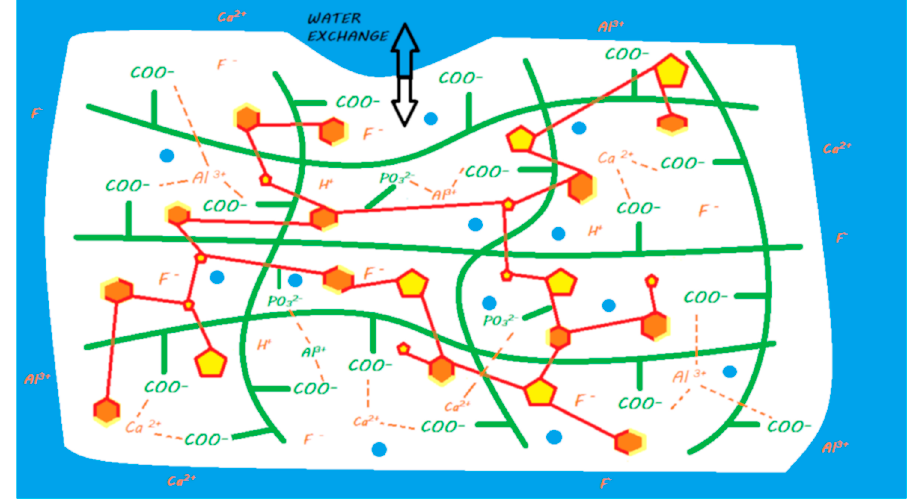
Figure 16. Diagram of ion release from Activa BioActive Restorative once it is in contact with a moist environment (i.e., oral environment). When the powder and liquid are mixed, the acid–base reaction is initiated, the setting of the material begins, and the FAS fillers are partially attacked. A silicic gel partially forms on the FAS filler surface. The released calcium and aluminum ions are able to form ionic bonds with ionized carboxylic groups. Fluoride ions are also released. A second reaction of resin polymerization occurs during mixing: monomers can copolymerize with silanated FAS fillers, silanated unreactive fillers, and other monomers. At the end of the reaction, we obtain two different interpenetrating networks with theoretical ionic links between both with trivalent ions. In water, calcium, aluminum, and fluoride ions (and eventually other ions) are able to be exchanged with the oral environment.